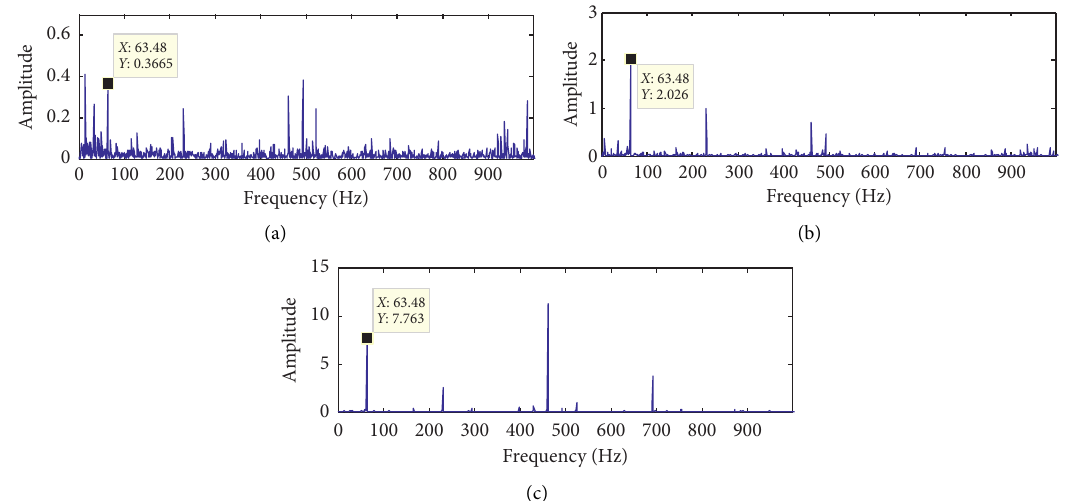
Figure 11: The envelope spectrums in the test for bearing 4# of testing 2 at different operating moments: (a) the trigger value of the proposed method at point 709, (b) the trigger value of the compared method at point 826, and (c) the breakdown value of the whole-life bearing at point